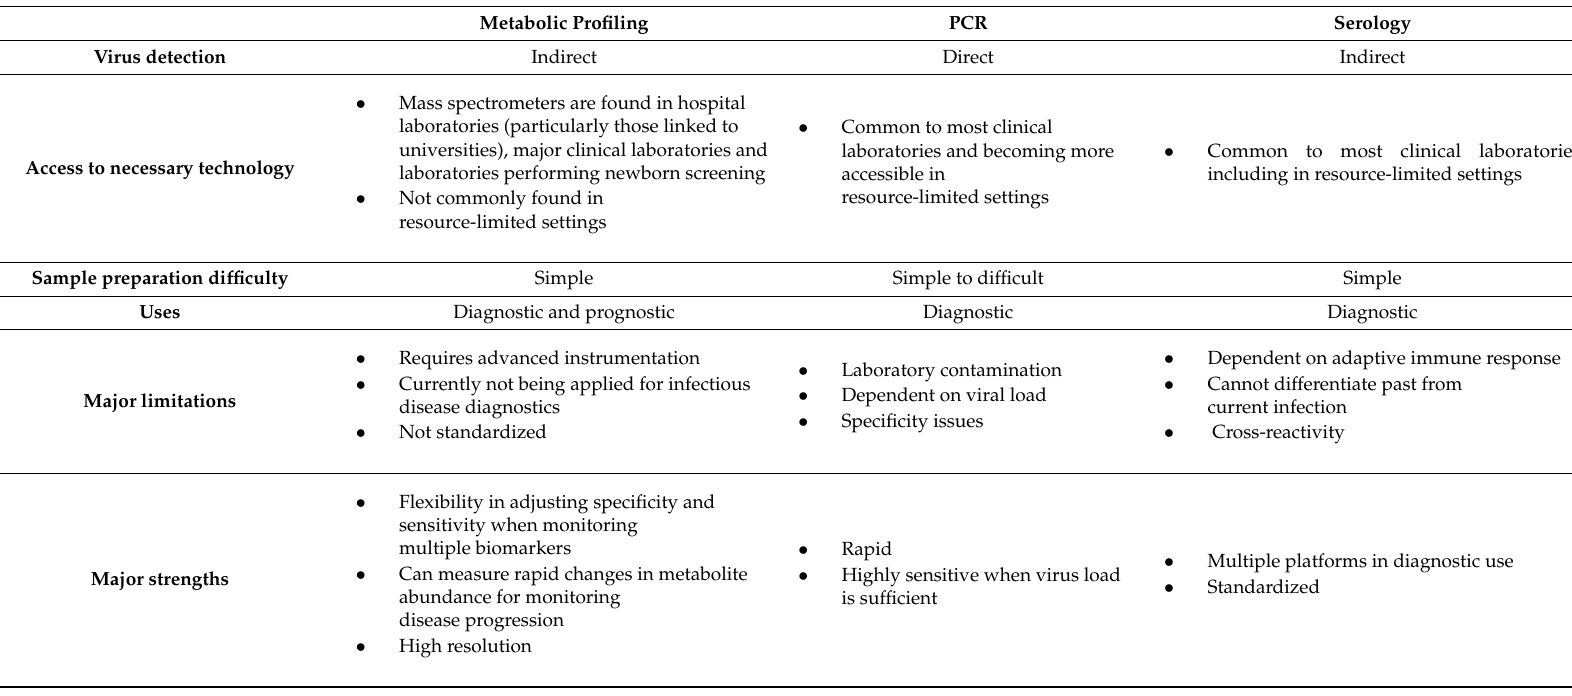
Table 5. Comparison of metabolic profiling, PCR, and serology techniques for assaying arbovirus